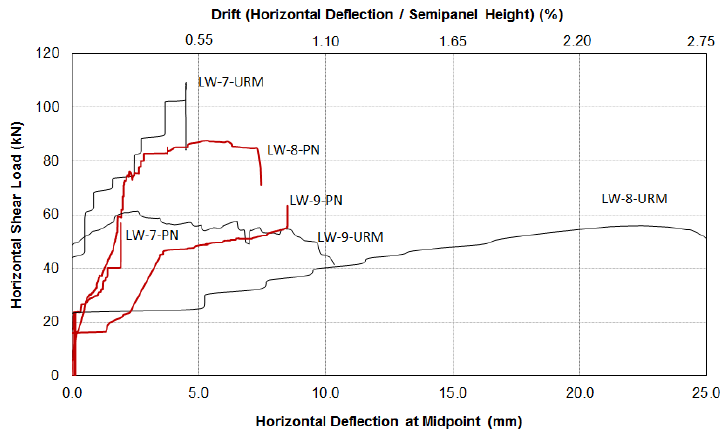
Figure 24. Shear load versus horizontal deflection / drift (black lines: URM panels, red lines: repaired with PN); the graphs are plotted using the shear loads of the semi-panels where failure